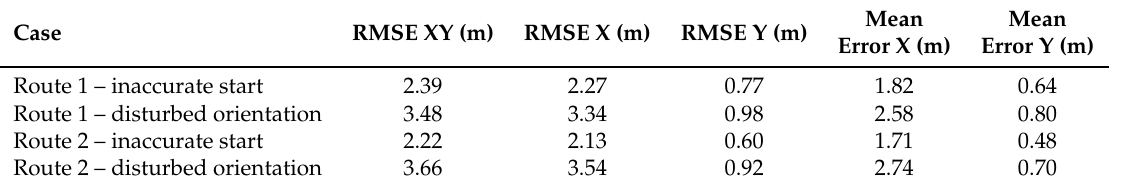
Table 3. Positioning accuracy of the four cases of Routes 1 and